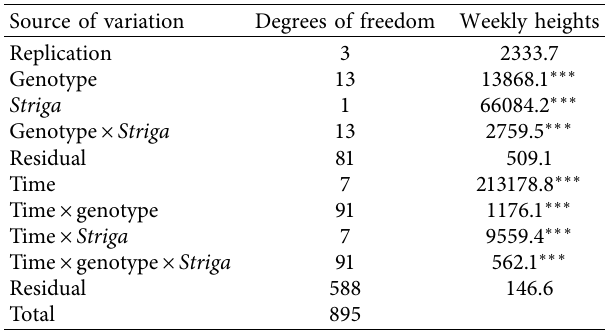
Table 5: Analysis of variance for maize plant height recorded for 2 nd WACE to 9 th